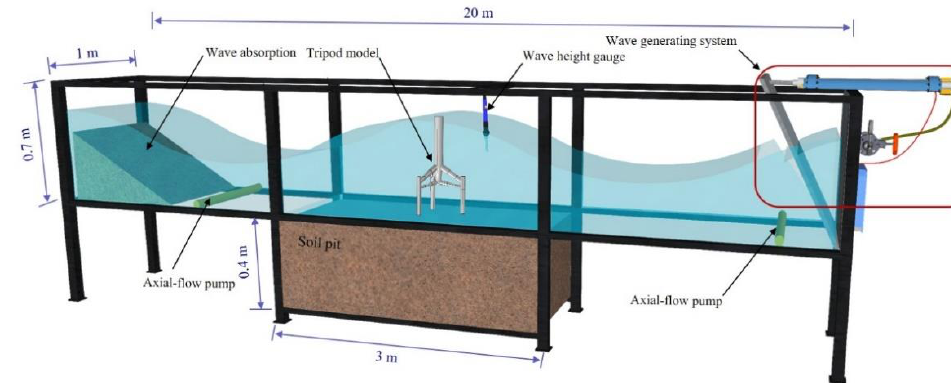
Figure 1. Schematic of the experiment system.